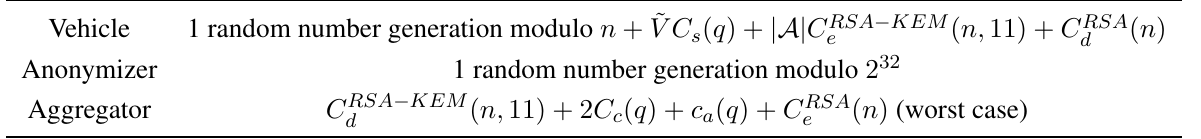
Table 3. Computational load at each node for the scheduling of a single service request.